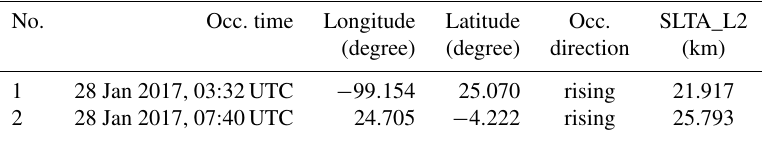
Table 2. Details of the selected bad occultations.